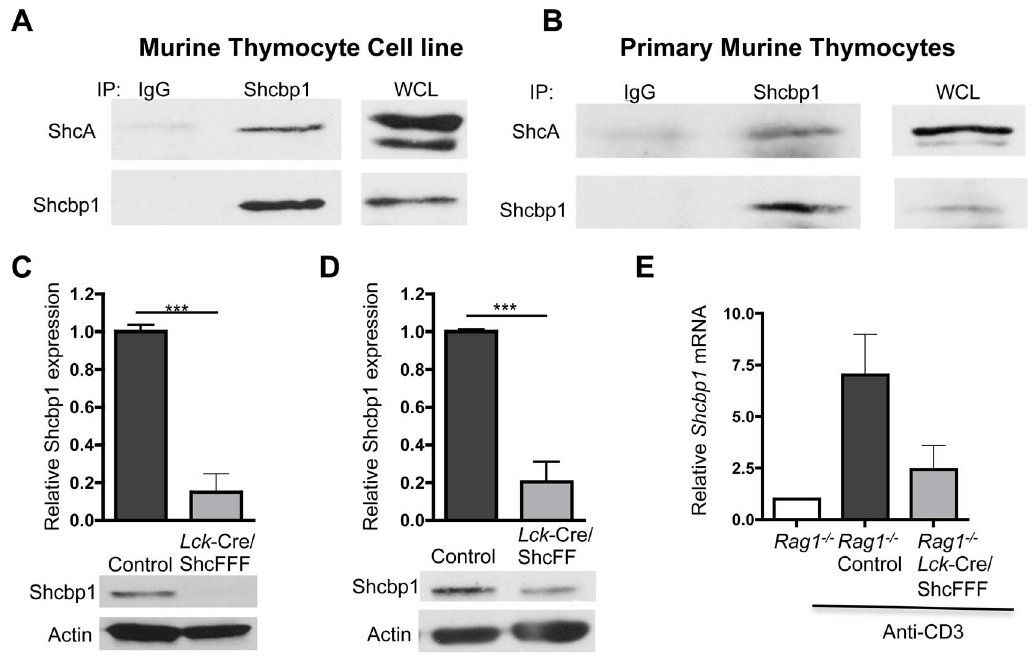
Figure 2. Shcbp1 expression is regulated downstream of ShcA signaling in the thymus. (A) Immunoprecipitation of Shcbp1 and immunoblotting for ShcA and Shcbp1 in the murine thymocyte cell line SCB29 (representative of n=3 experiments). (B) Immunoprecipitation of Shcbp1 and immunoblotting for ShcA and Shcbp1 in primary murine thymocytes (representative of n=2 experiments). (C) Shcbp1 expression in thymocytes expressing the ShcFFF transgene analyzed by immunoblotting in total thymocytes with quantification (n=9 control and n=5 Lck -Cre + / ShcFFF, p , 0.0001). (D) Immunoblotting of Shcbp1 expression in thymocytes expressing the ShcFFF transgene, along with quantification (n=4 control, n=3 Lck -Cre + /ShcFF, p=0.0003). (E) Shcbp1 mRNA expression in thymocytes from Rag1 2 / 2 or Lck -Cre + /ShcFFF Rag1 2 / 2 mice injected with either PBS or 100 m g of anti-CD3 for 24 hours (n=3 mice of each treatment, p=0.07).